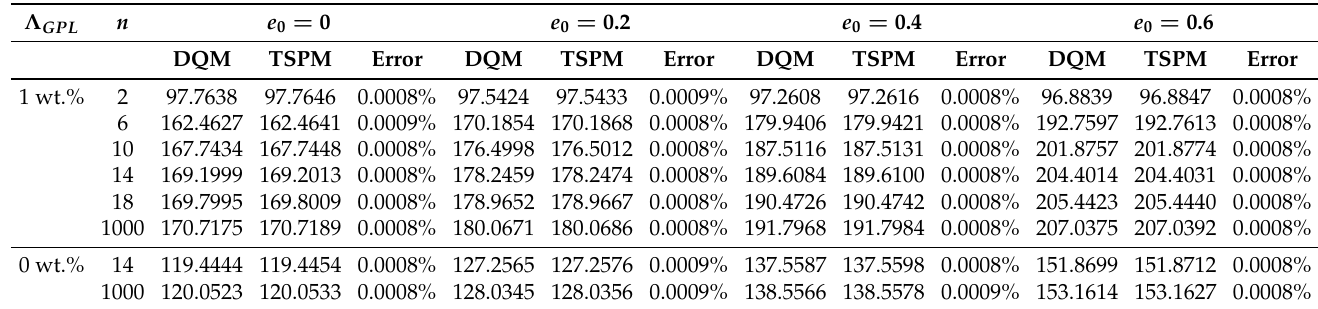
Table 3. The critical buckling temperature rise of H-H beams (porosity 1, GPL A, L / h = 20, K w = K s = 0).